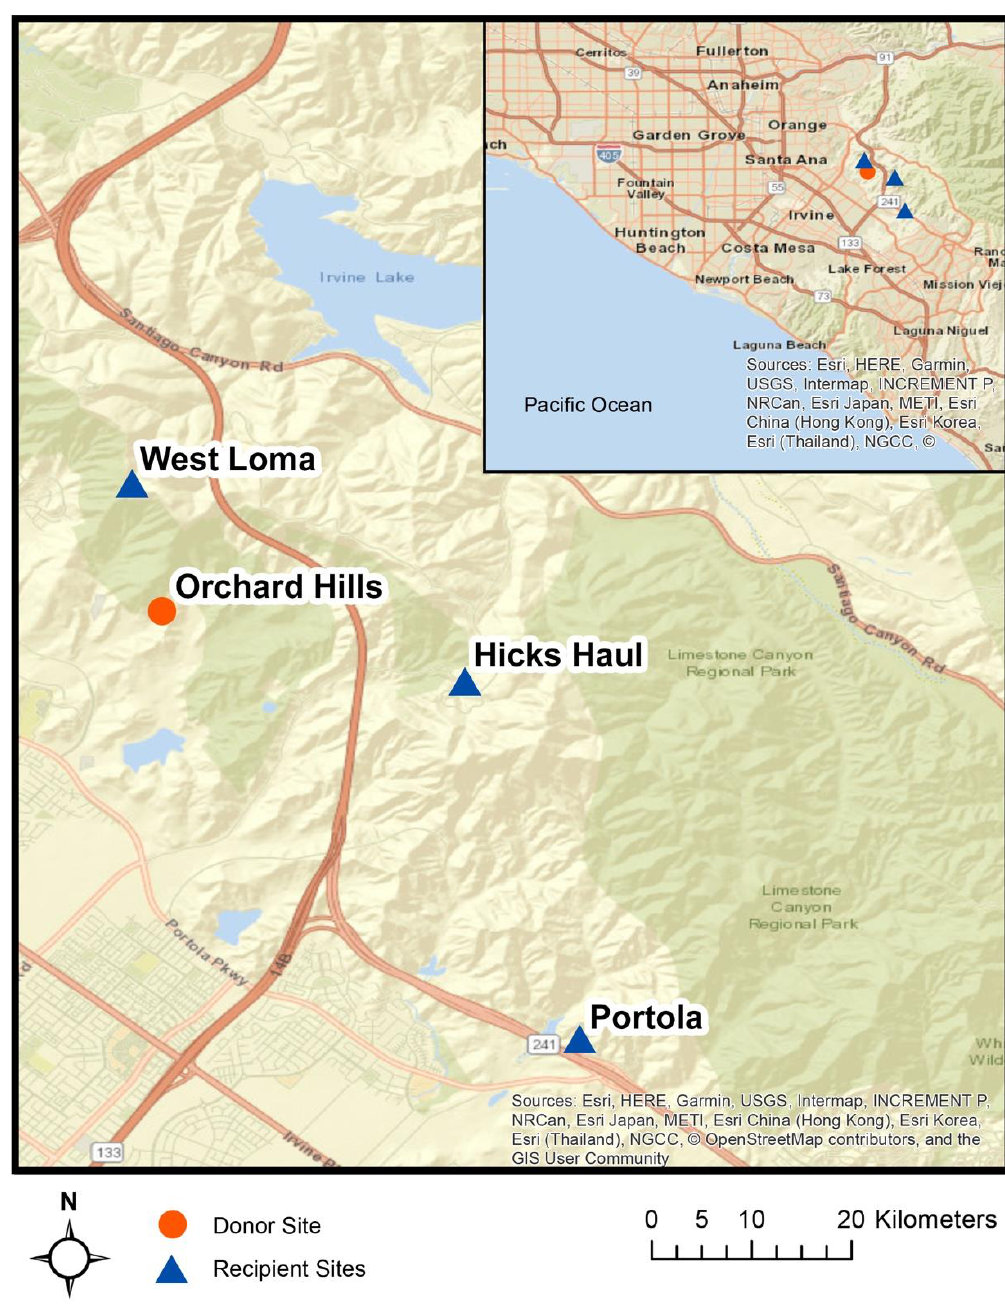
Figure 1. Map of study sites, including the donor site, Orchard Hills, from which soil was